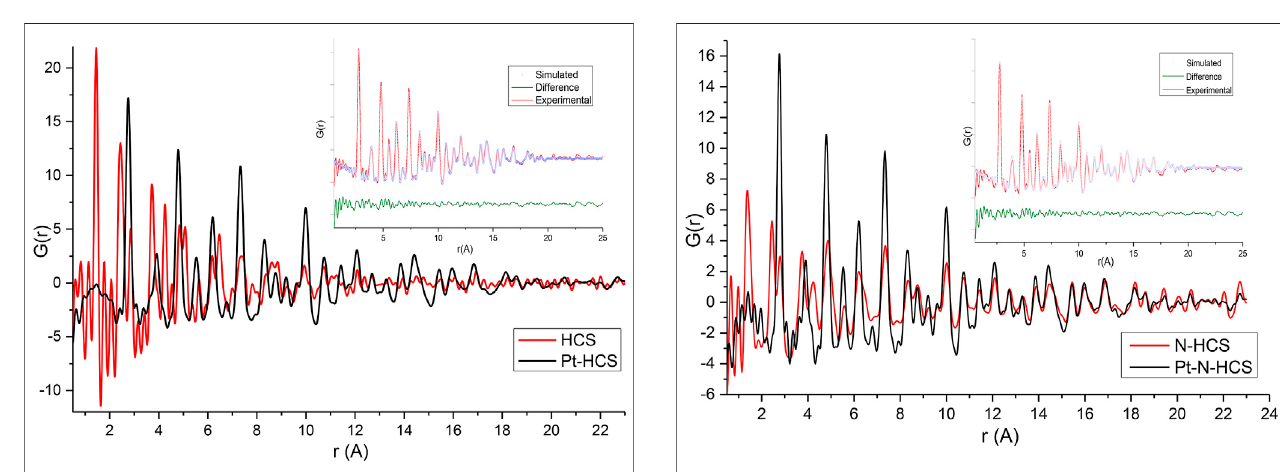
FIGURE4 | Experimental G(r) of HCSs and Pt/HCSs. Insert — shows the PDF fi tting of Pt/HCSs.